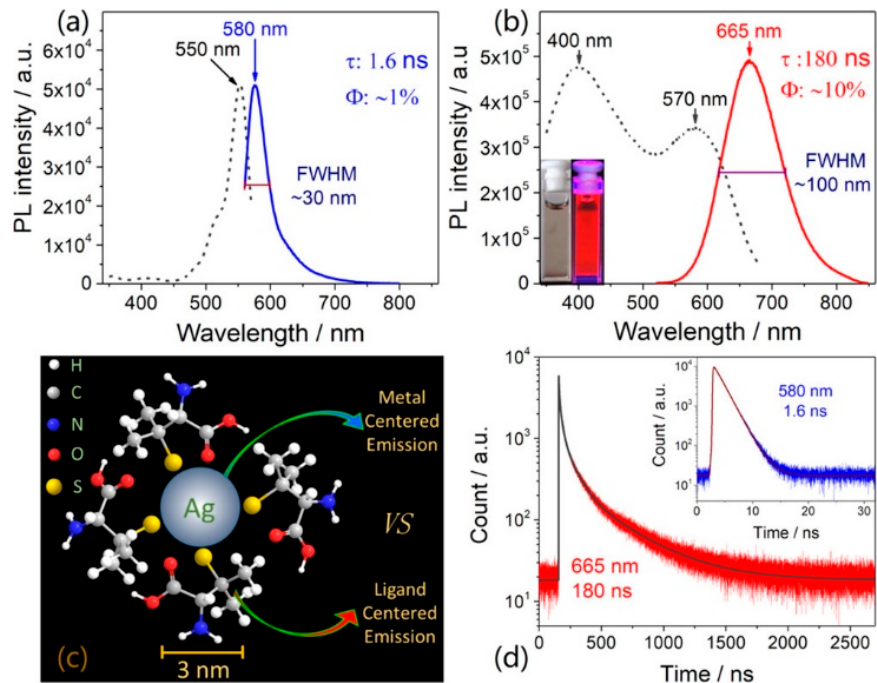
Figure 11. Excitation and emission spectra of the narrow approximately 580 nm emission ( a ) and broad approximately 665 nm emission ( b ). Inset images show the corresponding photographs of D-penicillamine-capped silver nanoclusters (DPA-AgNCs) under room and UV light exposure at λ = 365 nm. ( c ) Schematic illustration of the metal-centered and ligand-centered emission mechanisms of DPA-capped AgNCs. ( d ) Time-resolved luminescence decay profiles of DPA-AgNCs in water solution measured at 665 and 580 nm (inset), excited at 400 and 550 nm, respectively. Reprinted with permission from Ref. [87]. Copyright (2019) American Chemical Society.